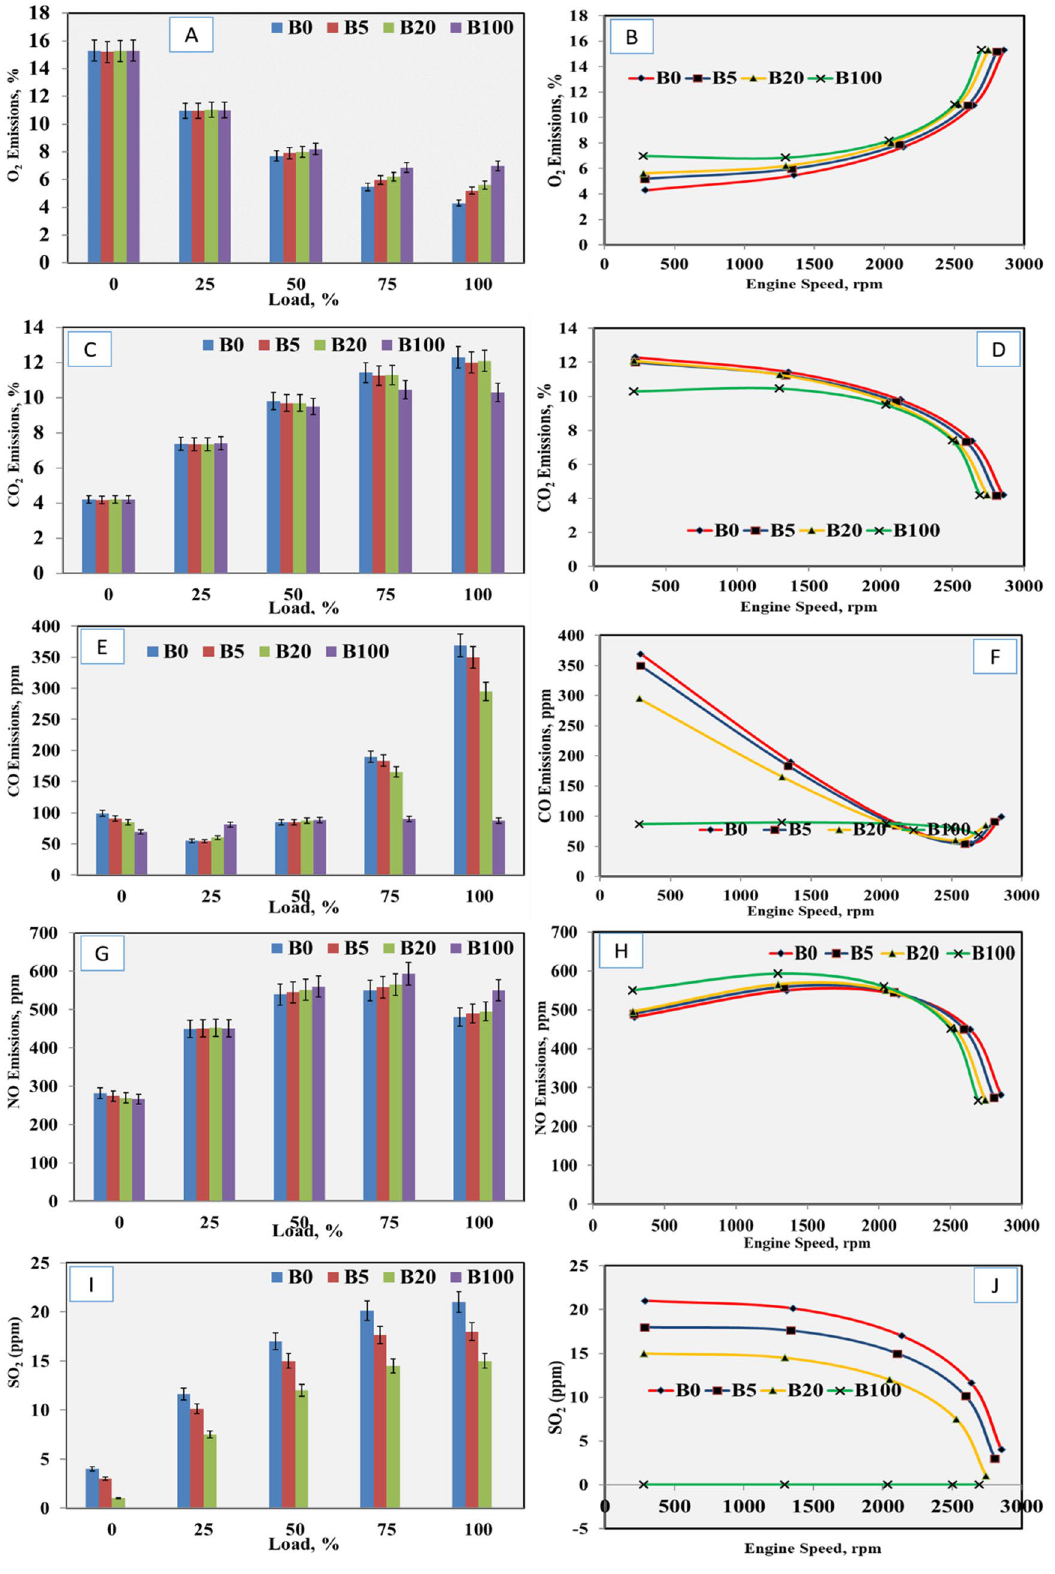
Figure 3. Effects of engine load on ( a ) engine load on O 2 emissions, ( b ) engine speed on O 2 emissions, ( c ) engine load on CO 2 emissions, ( d ) engine speed on CO 2 emissions, ( e ) engine load on CO emissions, ( f ) engine speed on CO emissions, ( g ) engine load on NO emissions, ( h ) engine speed on NO emissions, ( i ) engine load on SO 2 emissions and ( j ) engine speed on SO 2